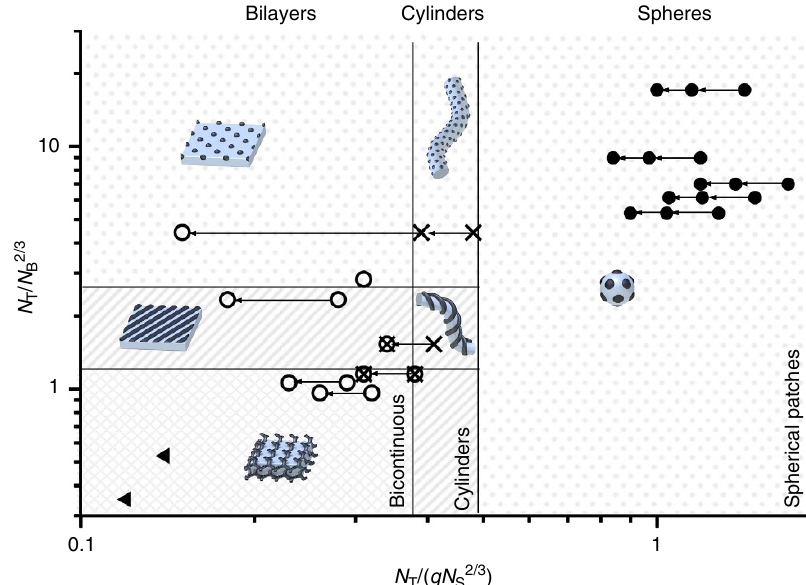
Figure 5 | Experimental phase diagram in dependence of relative block lengths. ( K ) Spherical micelles with spherical patches. (X) Cylinder micelles with spherical and double-helical patch morphology. ( # ) Mixtures of cylinder micelles and bilayers (structural transition). ( ) Bilayer sheets and vesicles with patchy, striped and bicontinuous membrane morphology. ( m ) Large terpolymer particles with inverse core morphology. All data points were corrected by swelling factor q (Supplementary Figs 1–4), where arrows ( ’ ) indicate same terpolymers, yet in solvents with increasing acetone